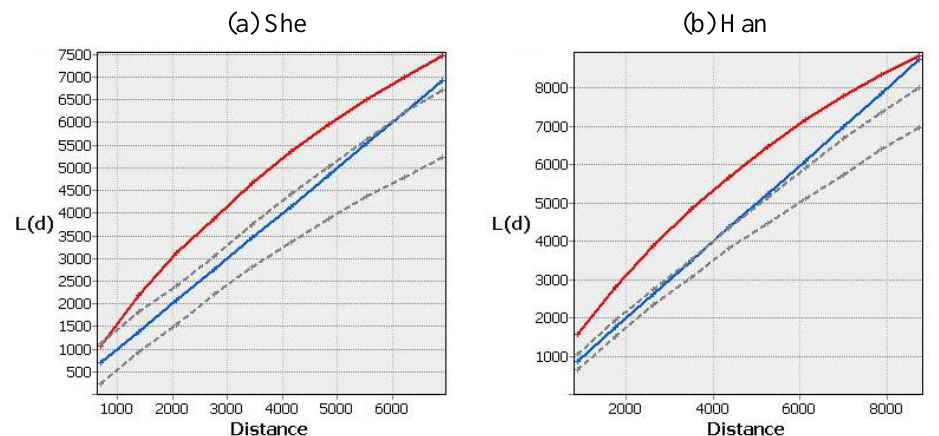
Figure 5. Scale features of spatial distribution of She nationality ( a ) and Han nationality ( b ) settle- ments. (Red line is the value of the L(d) function, blue line is the diagonal line, and gray line is the confidence interval.).